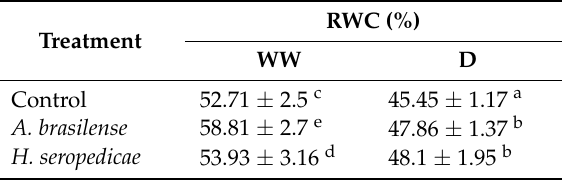
Table 1. Effect of inoculation on the relative water content (RWC) of plants in well-watered (WW) and drought (D) conditions. Means with common letters are not significantly different ( p > 0.05). Data are means of six replicates ± standard deviation (SD). The inoculation x drought interaction p < 0.0001.